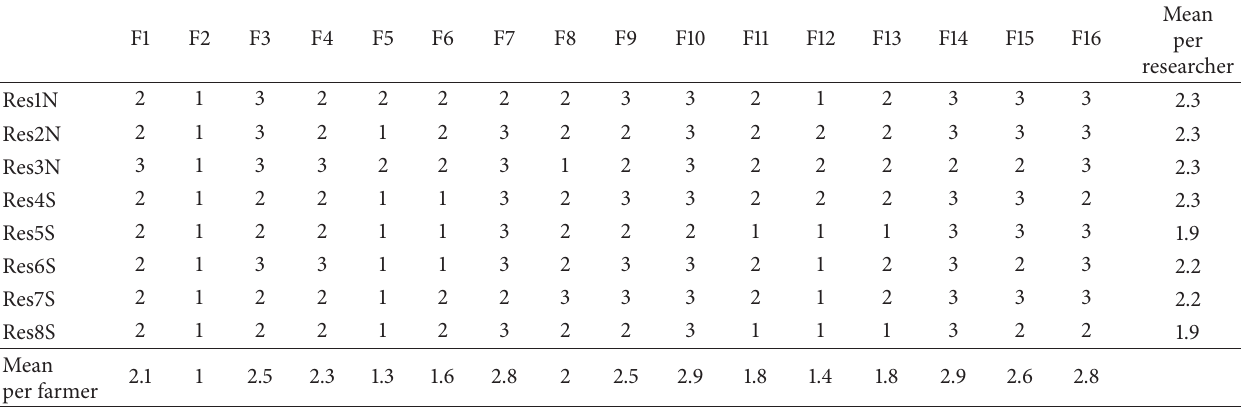
Table 4: Classification of farmer’s interest in nature per farmer (F) and per researcher (N mainly natural scientist and S mainly social scientist) doing the classification. The quotes that they based their classification on are shown in Table